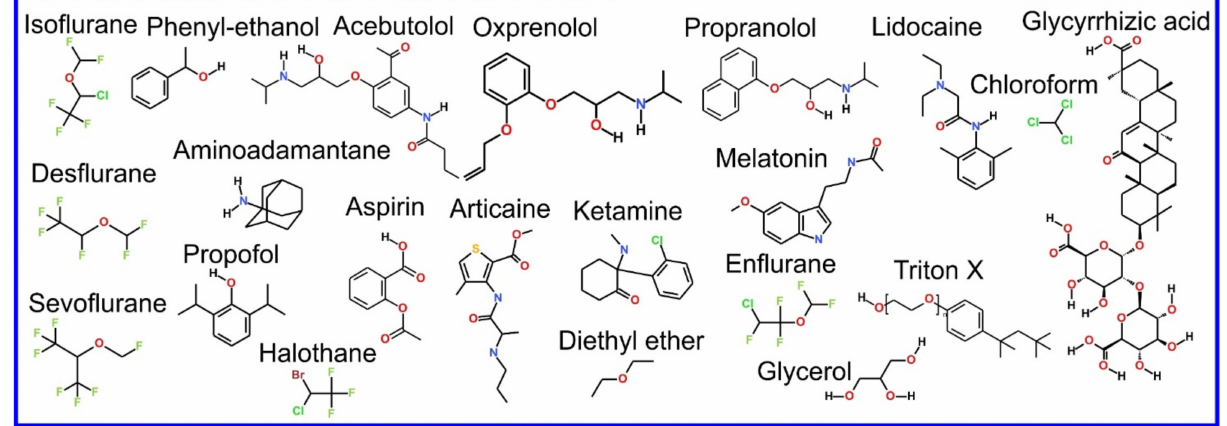
Figure 13. Chemical structure of drugs introduced in Section